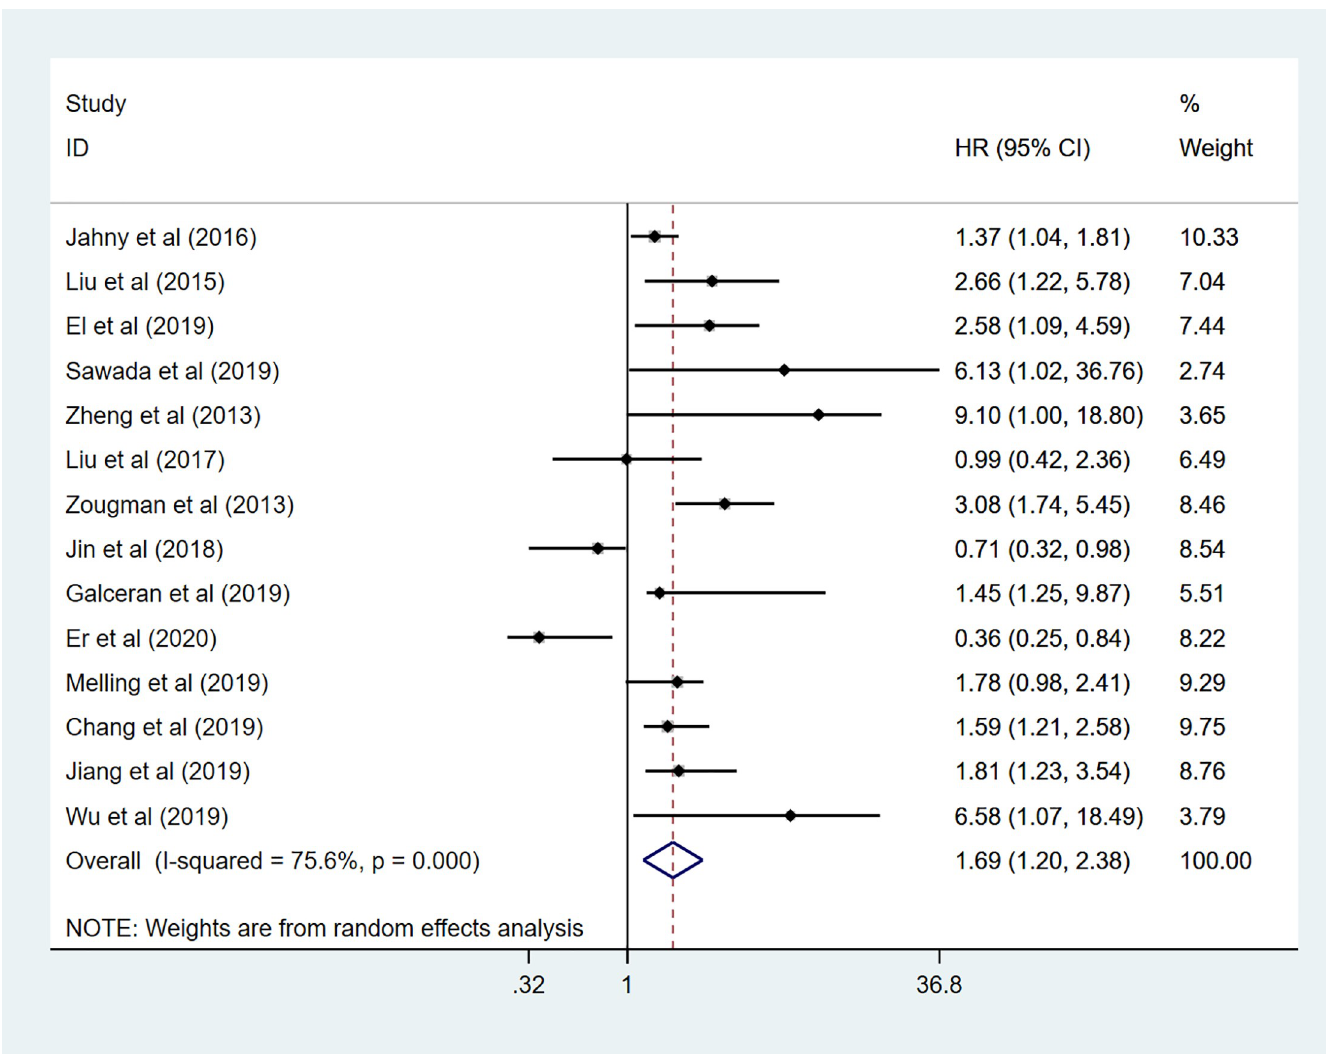
Fig 2. Forest plot for the association between GPRC5A expression and OS.